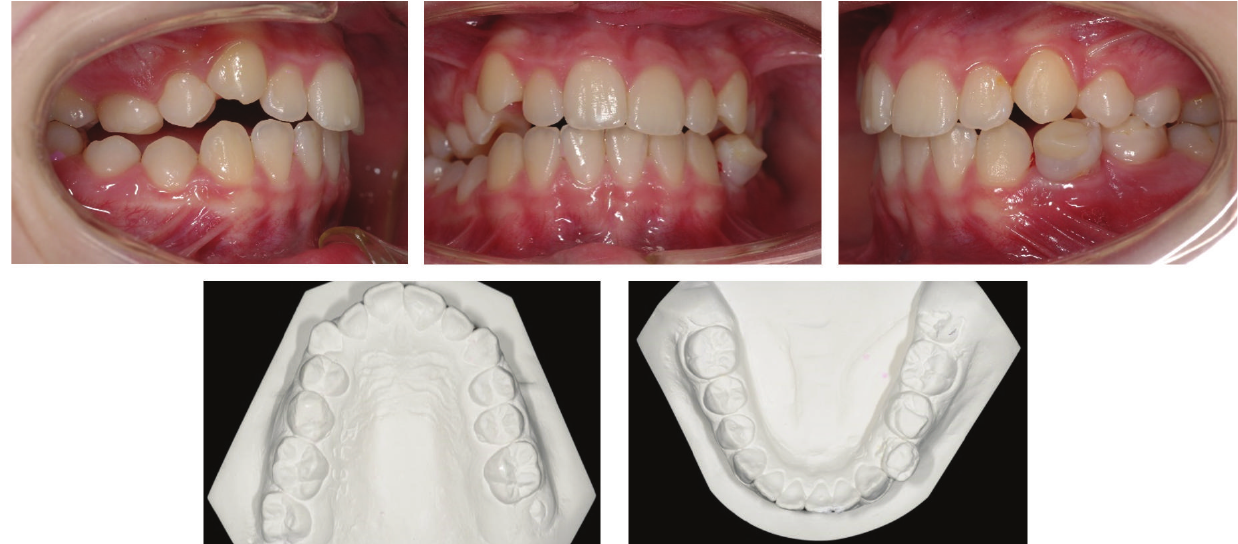
Figure 2: Pretreatment intraoral photographs and study casts (occlusal view).